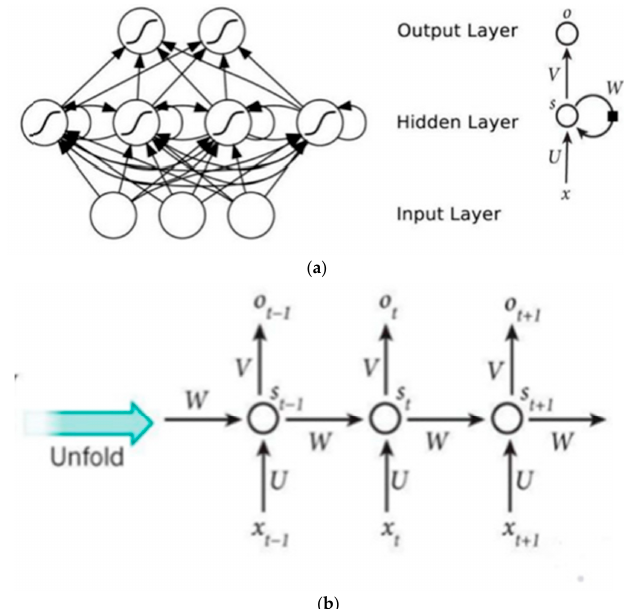
Figure 4. Analysis of ( a ) RNN structure and ( b ) RNN process.